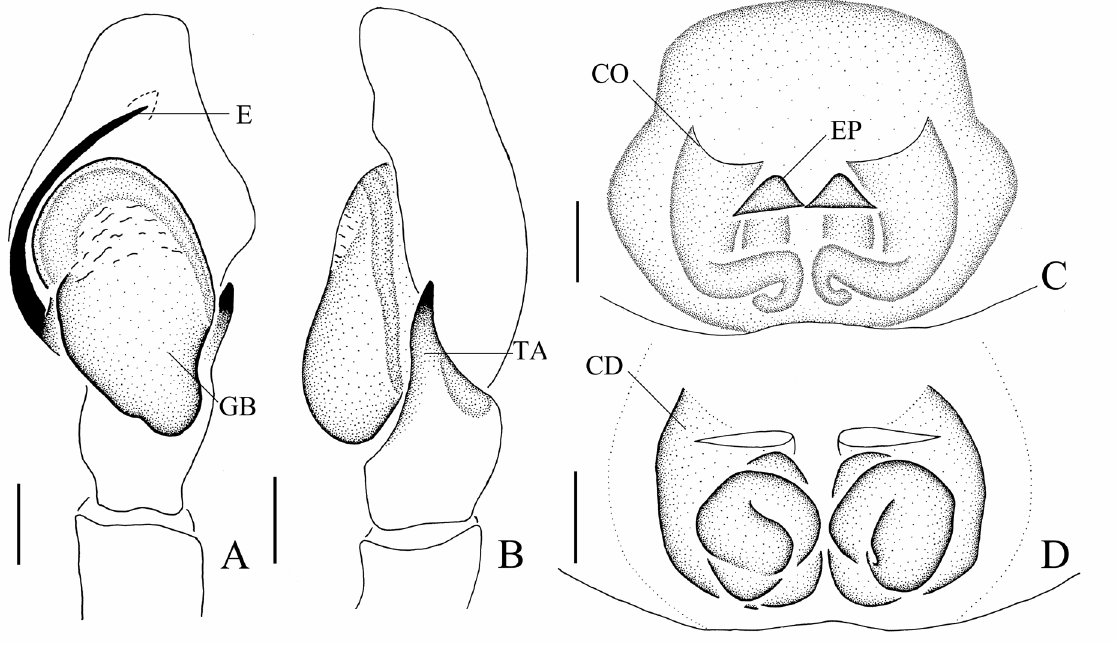
A . Male palp, ventral view. B . Male palp, retrolateral view. C . Epigyne, ventral view. D . Vulva, dorsal view. Scale bars: 0.2